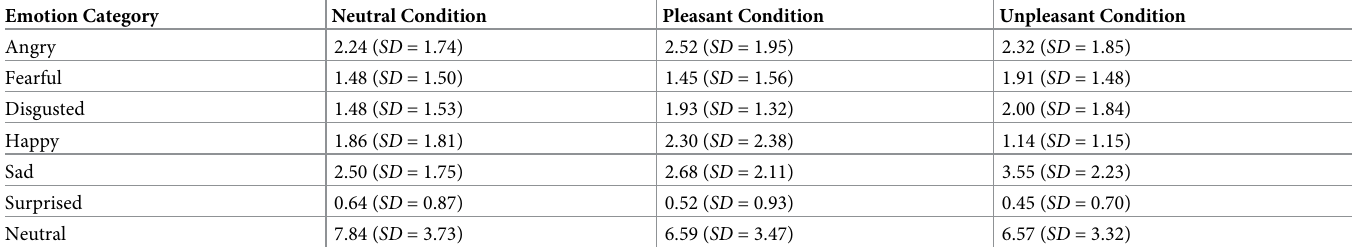
Table 1. Mean number of responses per emotional category (out of 18 possible responses per context condition) across neutral, pleasant, and unpleasant context conditions for face stimuli. Emotion Category